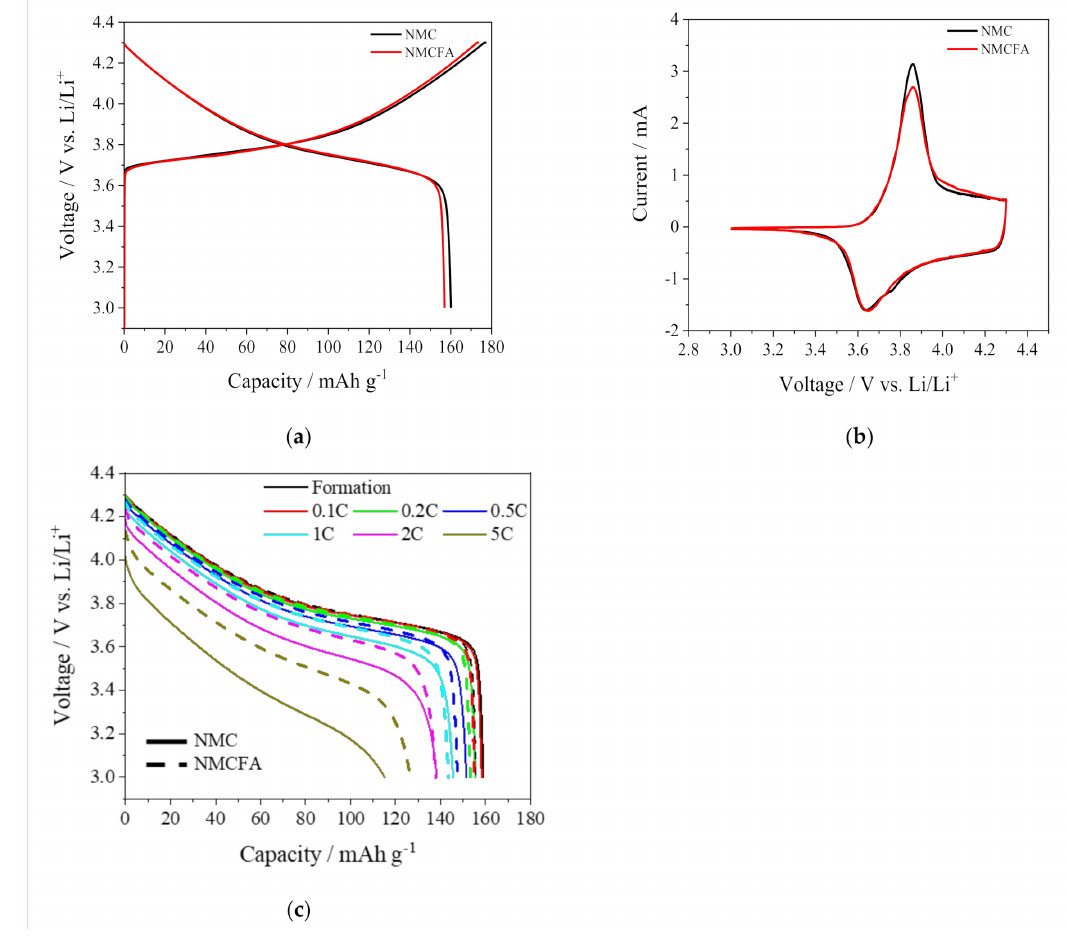
Figure 4. Comparison of the galvanostatic charge and discharge processes of NMC and NMCFA: ( a ) voltage profiles of initial cycling at 0.1 C, ( b ) initial cyclic voltammograms at a scan rate of 0.1 mV s − 1 , and ( c ) discharge curves at different C-rates from 0.1 to 5